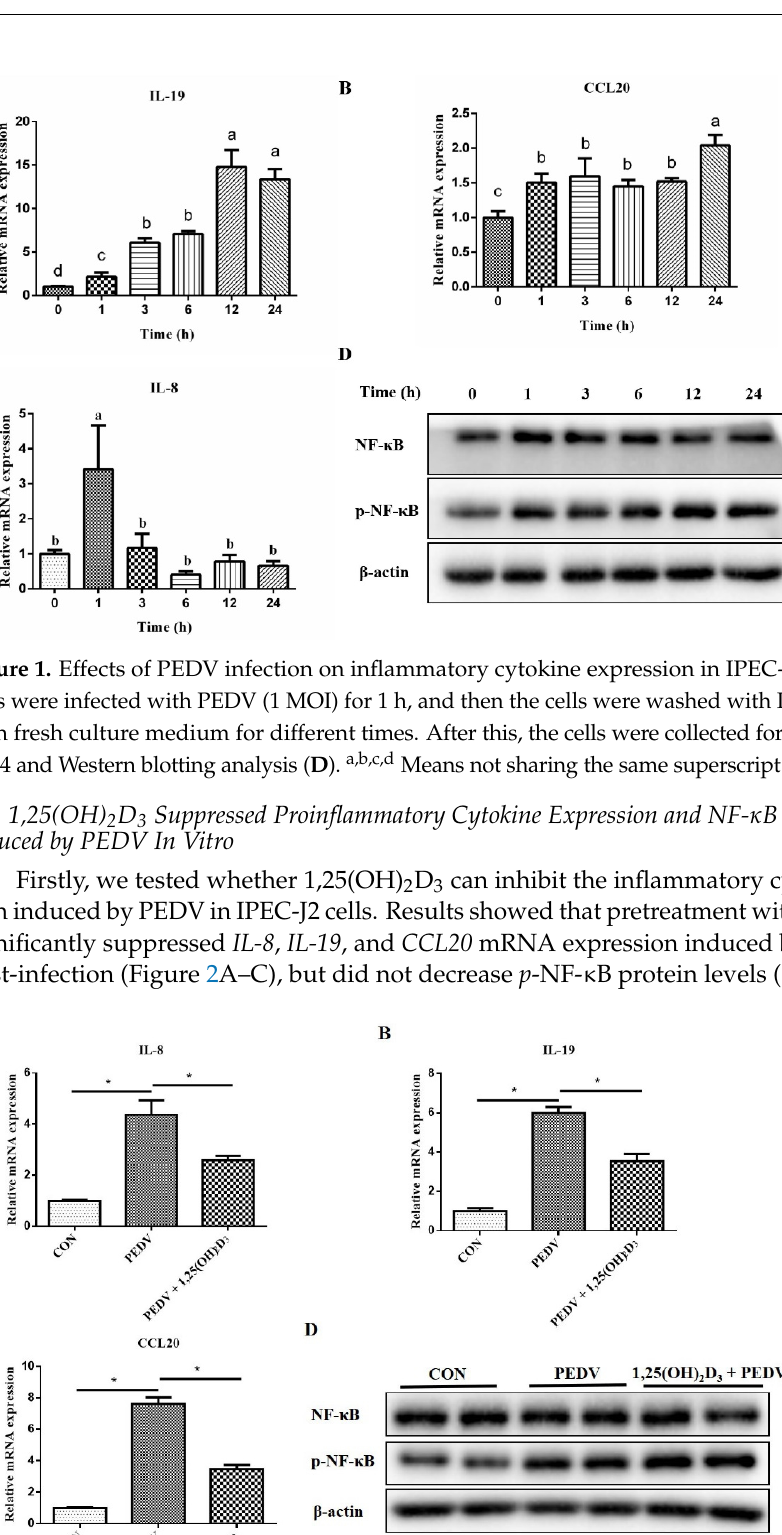
Table 1. Transcription analysis results of IL-19 and CCL20 (PEDV vs. CON).